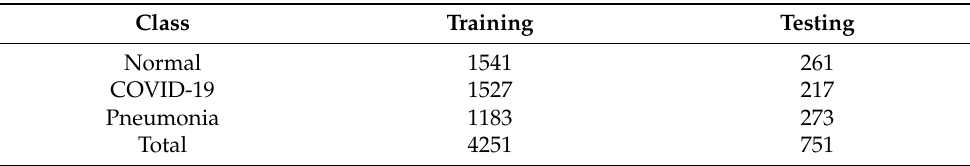
Table 12. Image distribution in the balanced X-ray dataset.